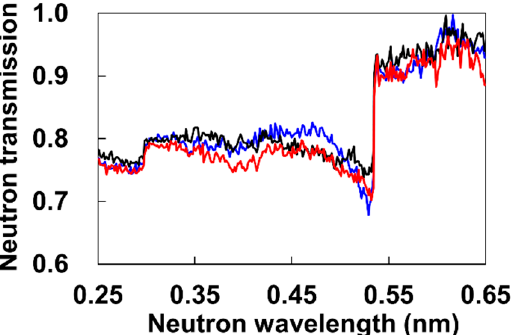
Figure 10. Example of neutron transmission spectra of 100% solid-phase LBE obtained from different points. The colors of the spectra are just for the visibility.